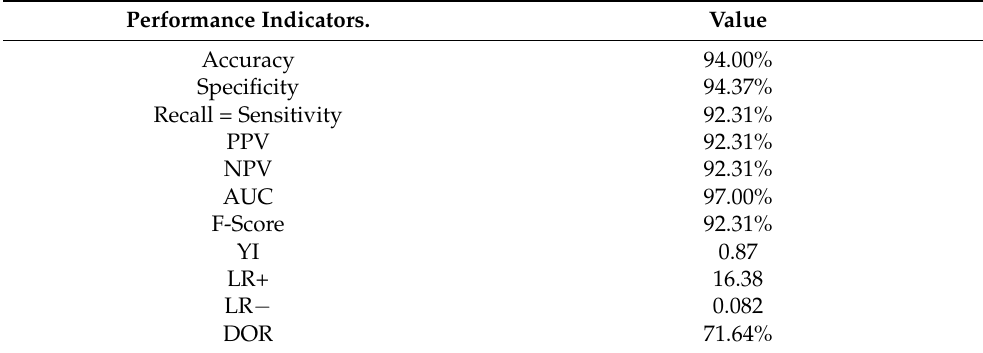
Table 5. Performance of the diagnostic model according to several key performance indicators. Performance Indicators.